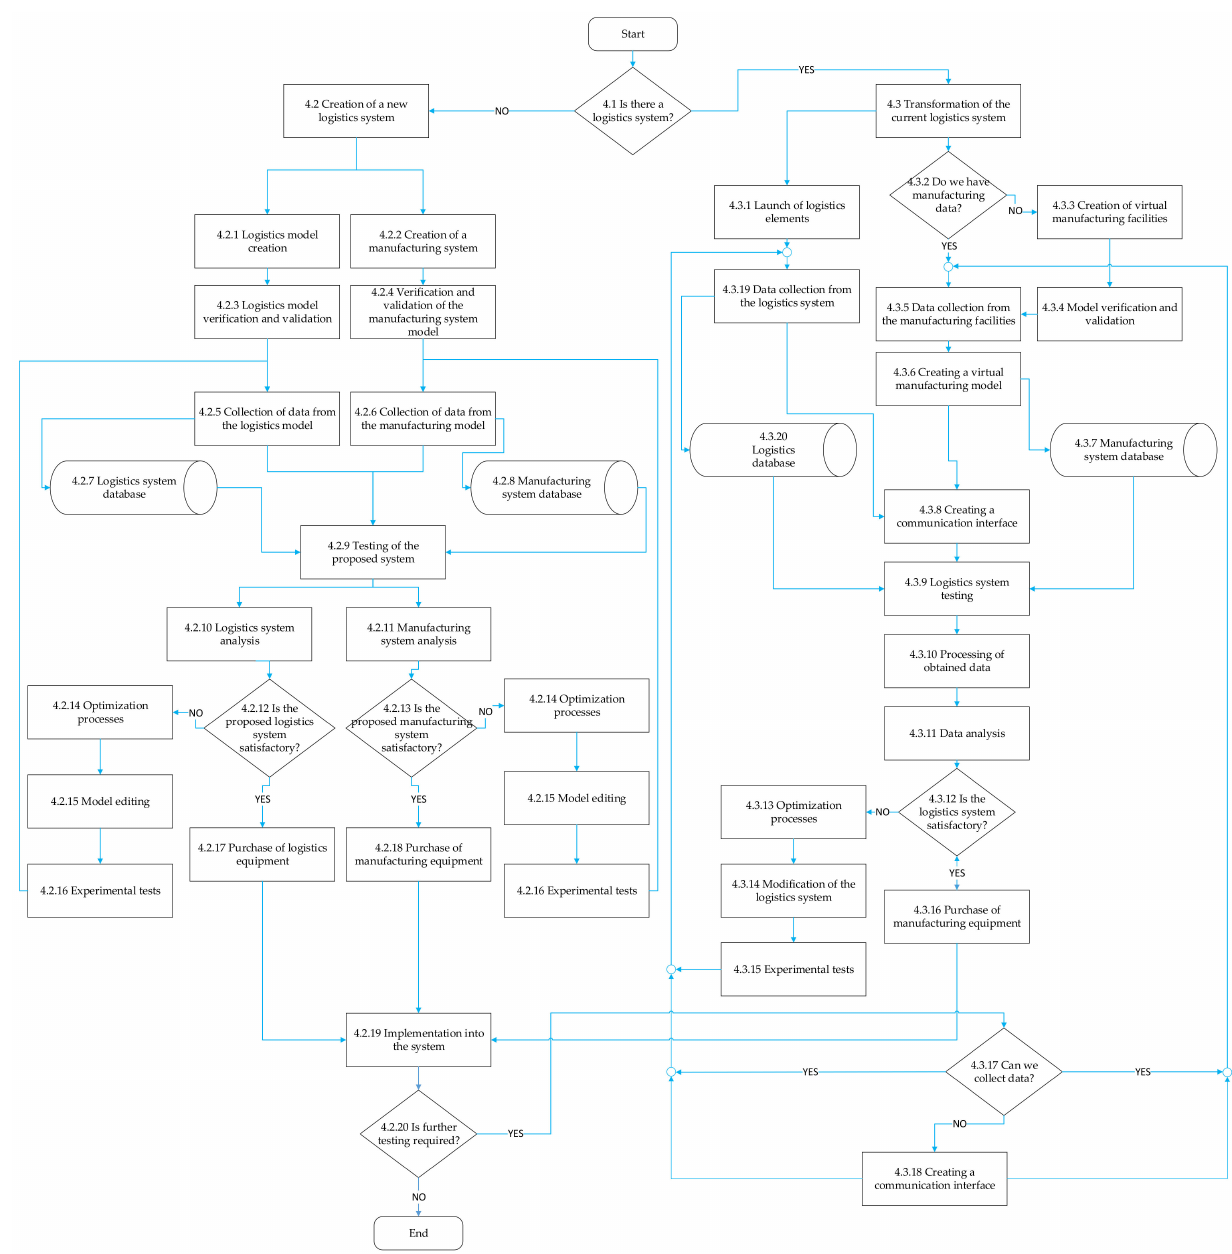
Figure 6. The emulation-simulation modelling